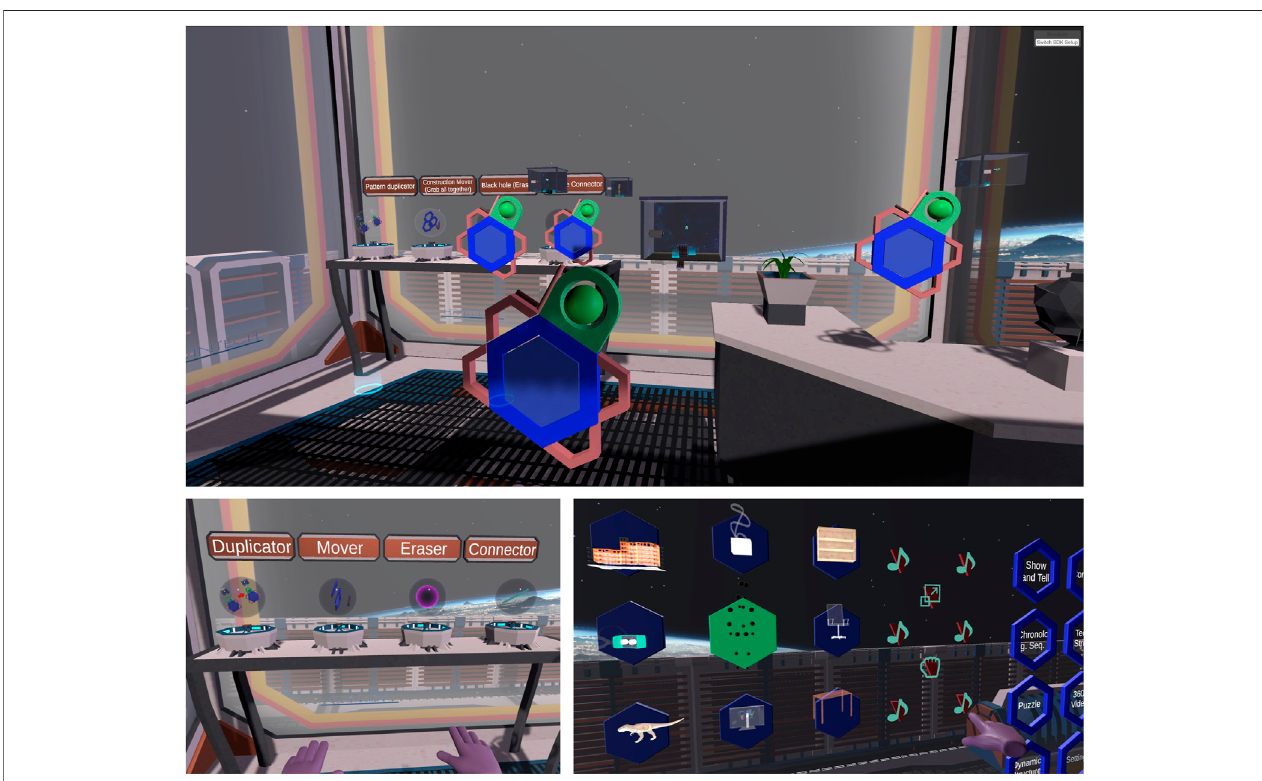
FIGURE4| IllustrationsofINTiles ’ sUIwithintheauthoringroom.Top:Tile-likeaffordancesrepresentingVRnuggetcomponents.Bottomleft:Meta-authoringtools attheauthorsdisposal(e.g.,aconnectortooltolinkVRnuggetsandbringthemintoatimelyexecutionorderfordeployment).Bottomright:Individualtile-likeaffordances illustrating their underlying assets.